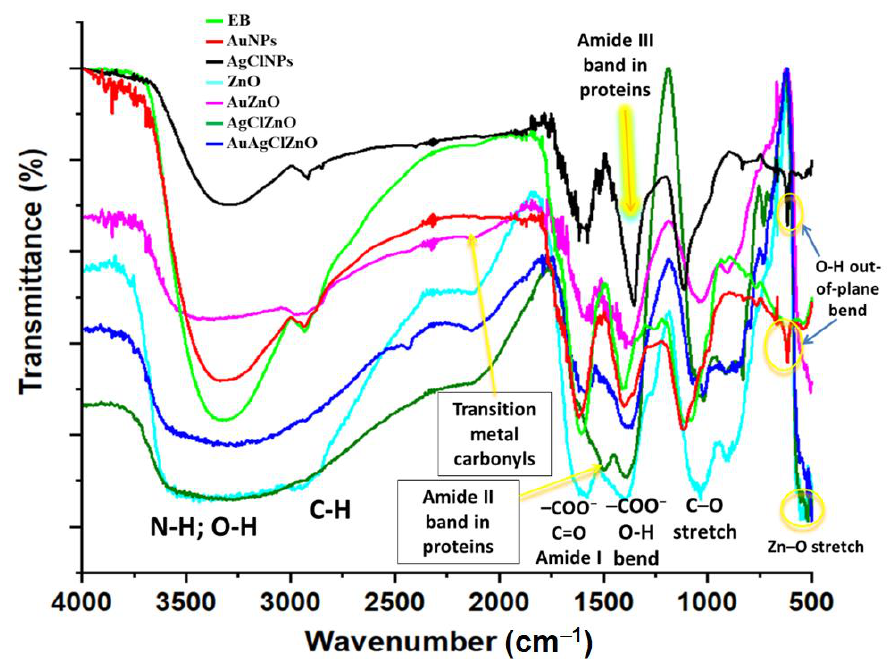
Figure 2. Comparative presentation of FTIR spectra of burdock extract and of burdock-derived par- ticles.